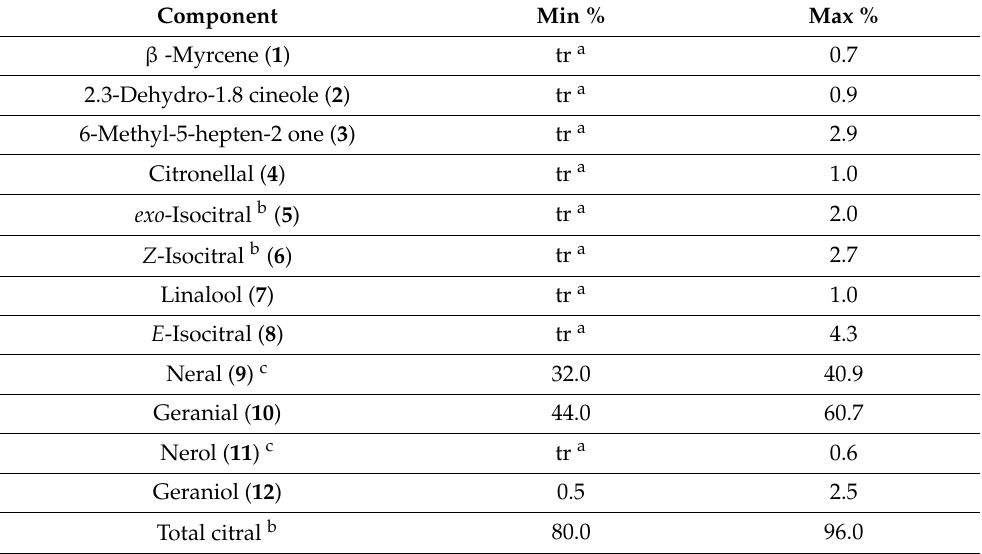
Table 2. The percentage proportion ranges for key constituents in the essential oil of the citral chemotype of Backhousia citriodora .